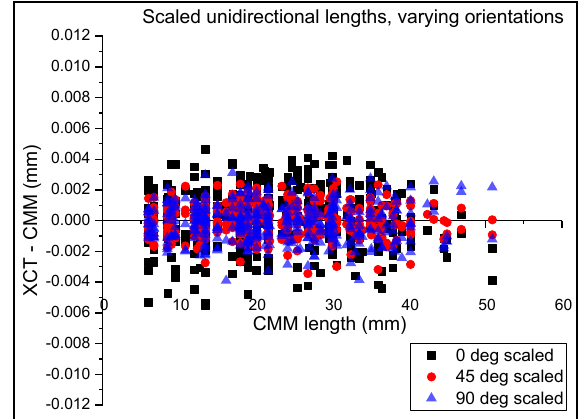
Figure 9: Scaled deviation between unidirectional lengths for holeplate at 1.6 times magnification in three